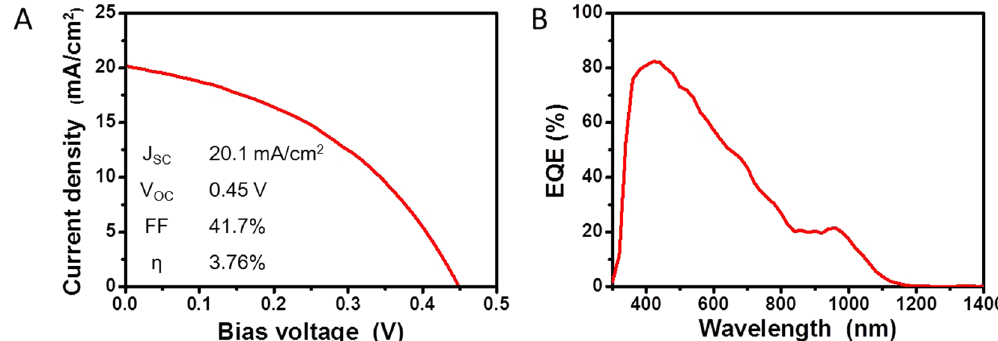
Figure 6. ( A ) J – V curves obtained under AM1.5G illumination and ( B ) EQE spectra of solar cells with PbS QD heterojunction with graded architecture and having the structure glass/FTO/TiO 2 /PbS-PbI 3 _MPA/PbS-MPA/ MoO x /Au/Ag, which was formed by spray